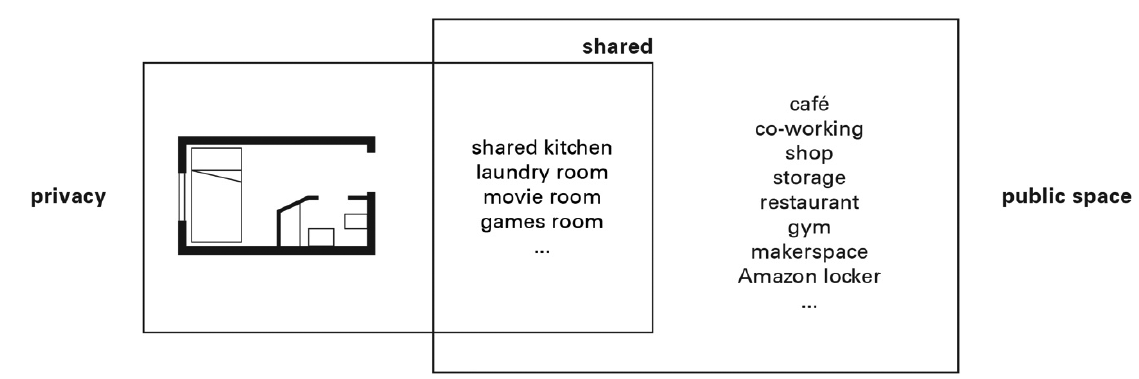
Figure 1. Conceptual diagram of co‐living, showing the functional breakdown from privacy to public